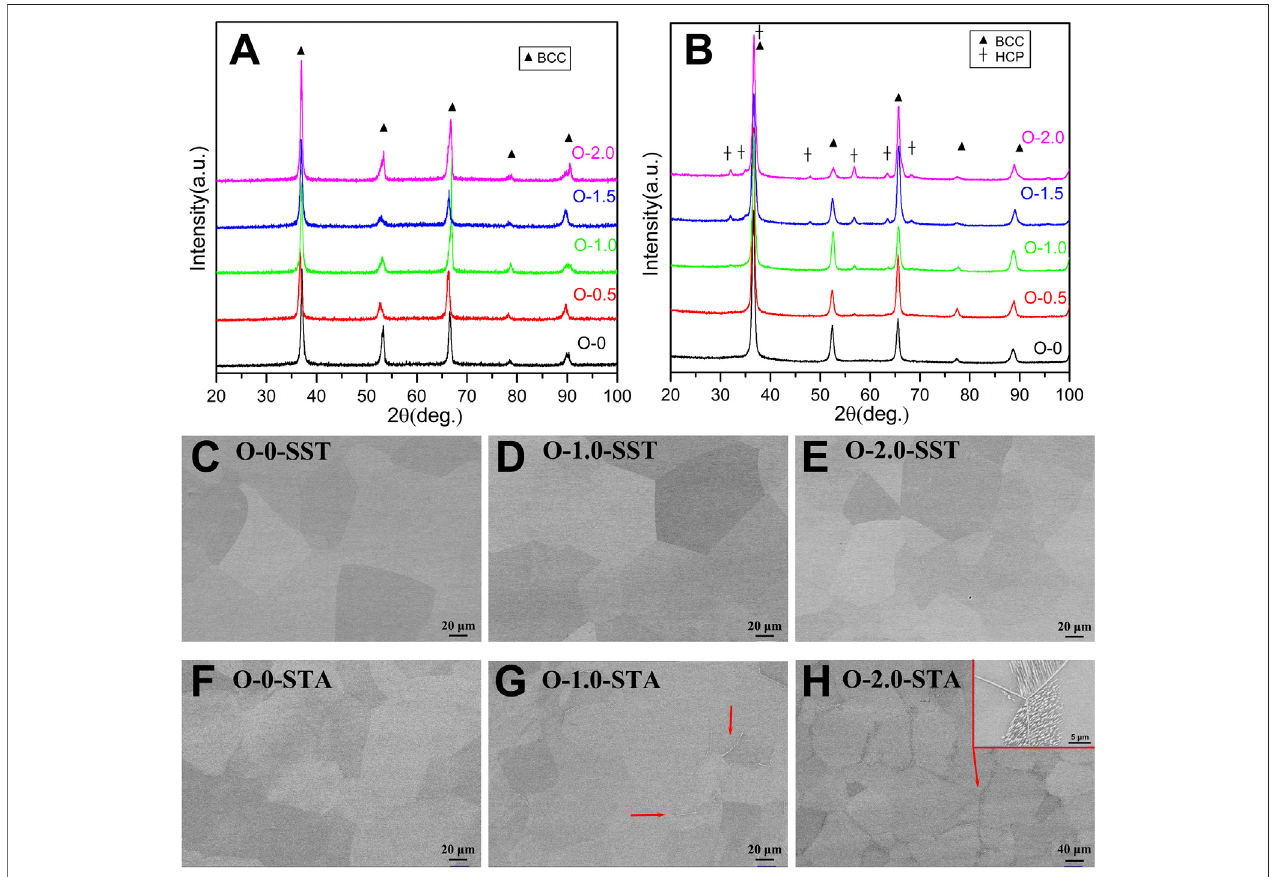
FIGURE 1 | X-ray diffraction patterns for TiZrHfNbO HEAs with different O concentrations in (A) SST and (B) STA states; Representative back scattering SEM images for SST and STA specimens with different O contents, (C) O-0-SST, (D) O-1.0-SST, (E) O-2.0-SST, (F) O-0-STA, (G) O-1.0-STA and (H) O-2.0-STA.